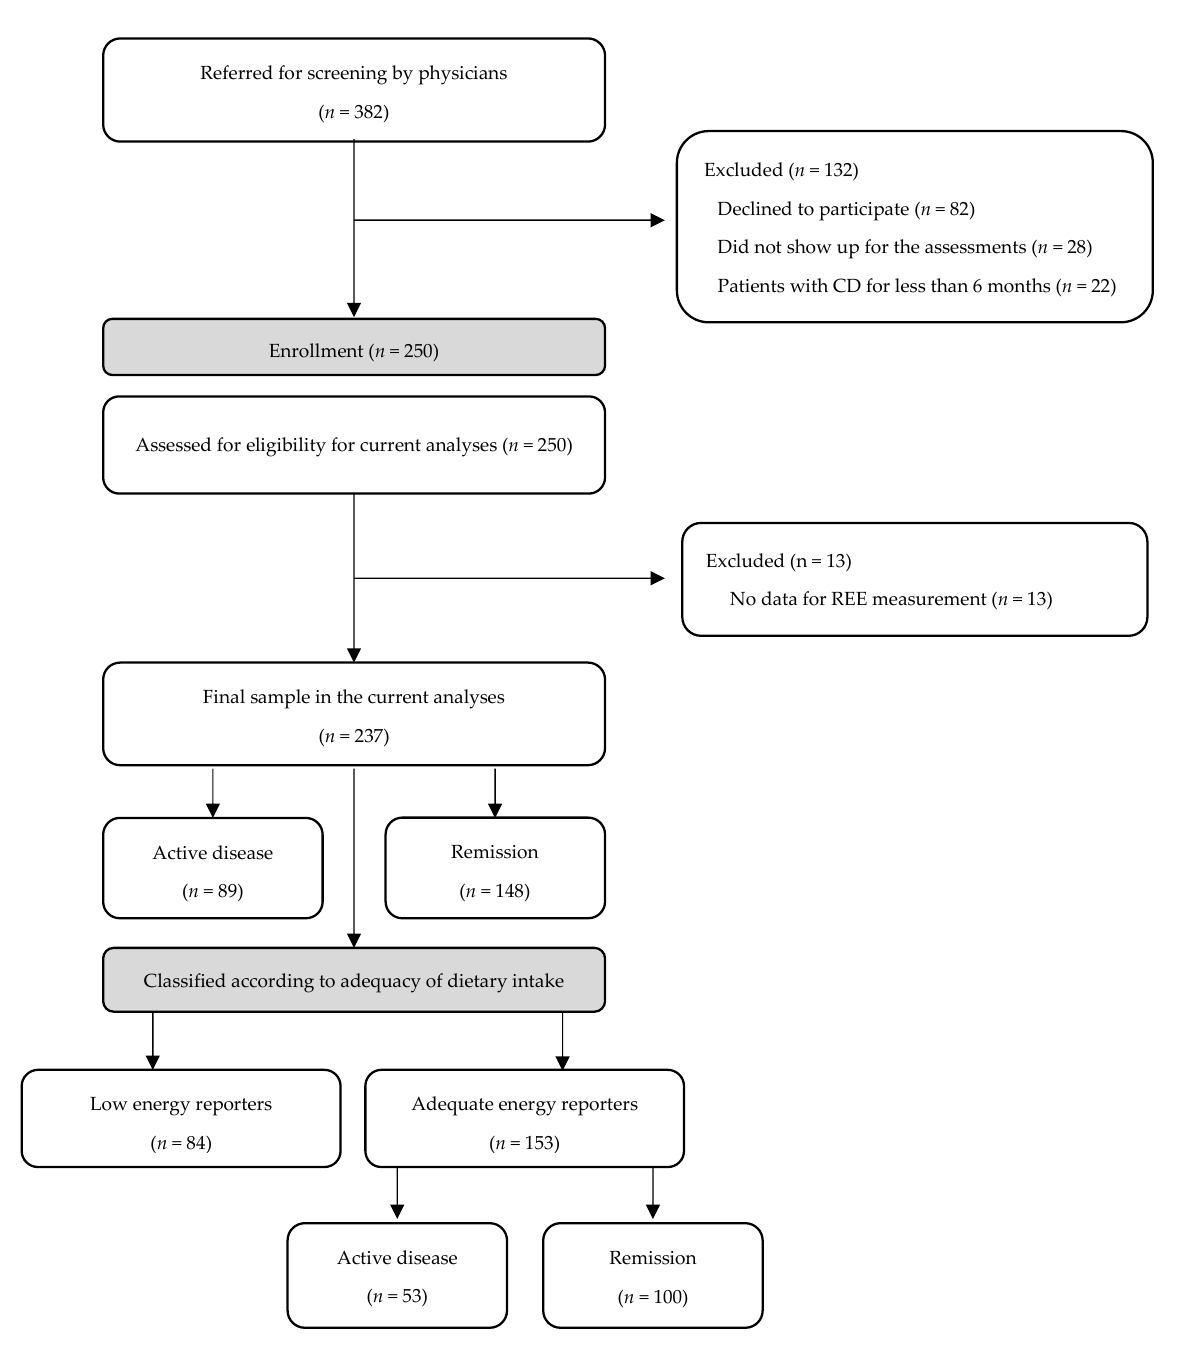
Figure 1. CONSORT chart. From November 2018 to November 2019, 382 patients with CD were referred by collaborating physicians for screening. Of the 382 patients, 82 declined to participate, 28 did not show up for the assessments and 22 were diagnosed with CD for less than 6 months. In total, 250 patients with CD included in a cross-sectional evaluation of nutritional status, were assessed for eligibility in the current analyses. Thirteen patients were excluded from the present analyses, because of missing data regarding REE measurement, leading to a final sample of 237 patients. Of the final sample, 89 patients were in active disease and 148 in remission. Four patients were on a weight loss diet and the rest were further classified according to adequacy of dietary intake based on Goldberg et al. criteria to 80 low energy reporters and 153 adequate energy reporters. Among the adequate energy reporters, 53 had active disease and 100 were in remission. Abbreviations: CD: Crohn’s Disease, REE: Resting Energy